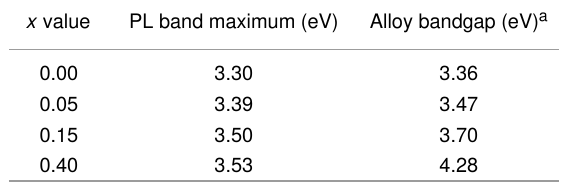
Table 1: The PL band spectral position and the bandgap value for ZnMgO films at room